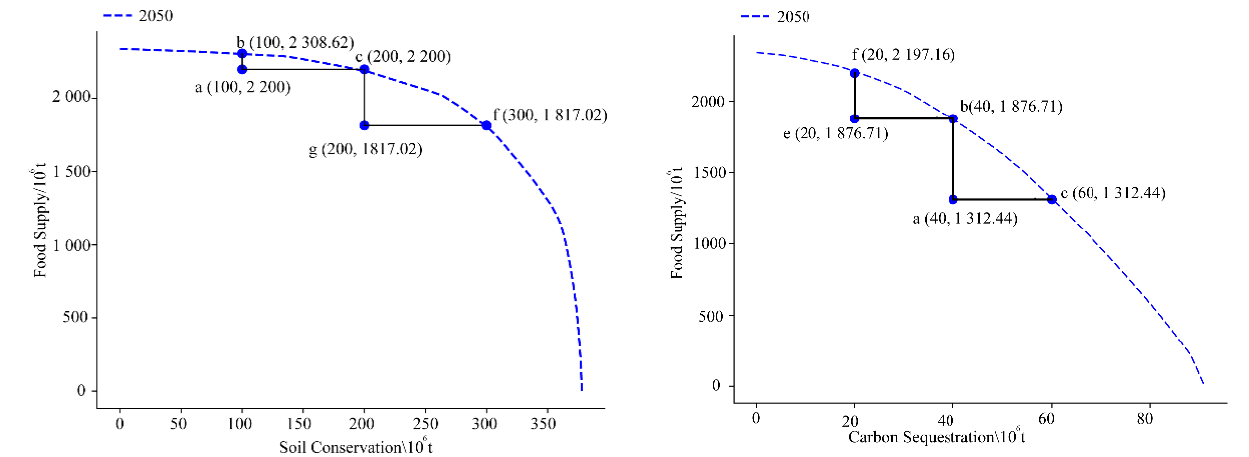
Figure 8. PPF curves between the food supply and soil conservation and carbon sequestration.